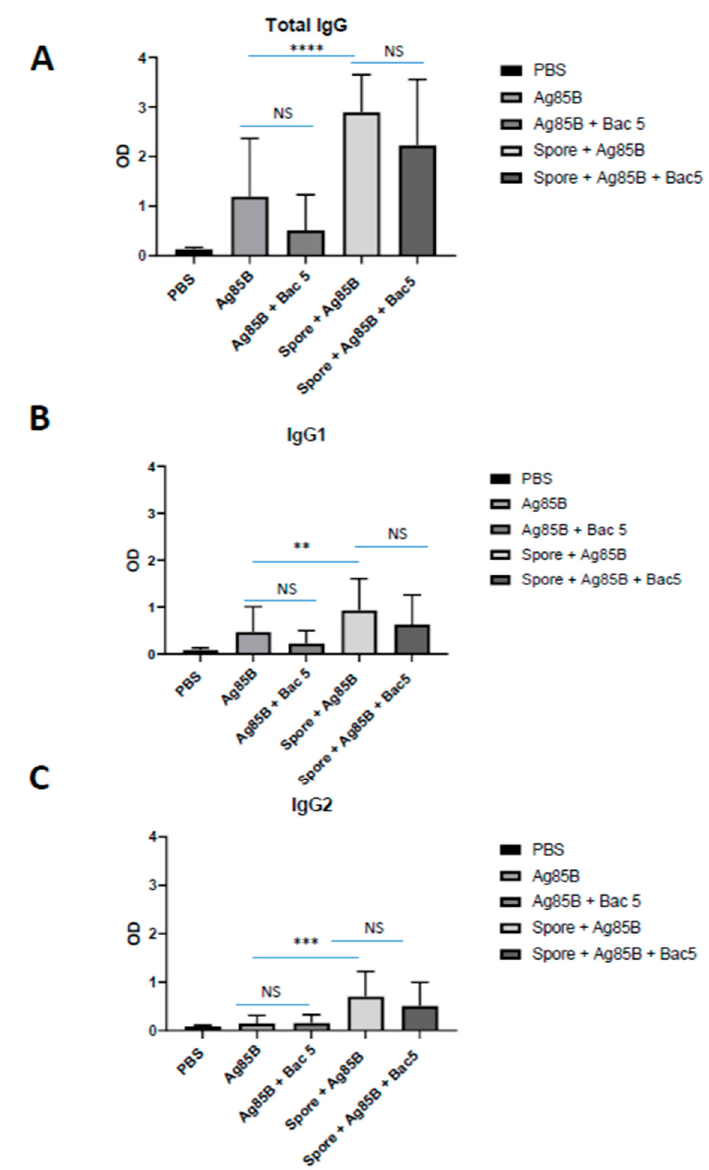
Figure 7. Statistical Analysis of Adjuvant Effect. The sum total optical density values from each condition, as generated by IgG ELISA, including all biological replicates (n = 3) (see Figure 6) was used to calculate the mean values with standard deviation from each immunisation condition to allow statistical comparison. Analysis was performed individually for total IgG ( A ), IgG1 ( B ) and IgG2 ( C ) subclasses. one-way ANOVA with multiple comparisons was performed between groups (**** = p < 0.0001, *** = p < 0.001, ** = p < 0.01, NS = No Significance).